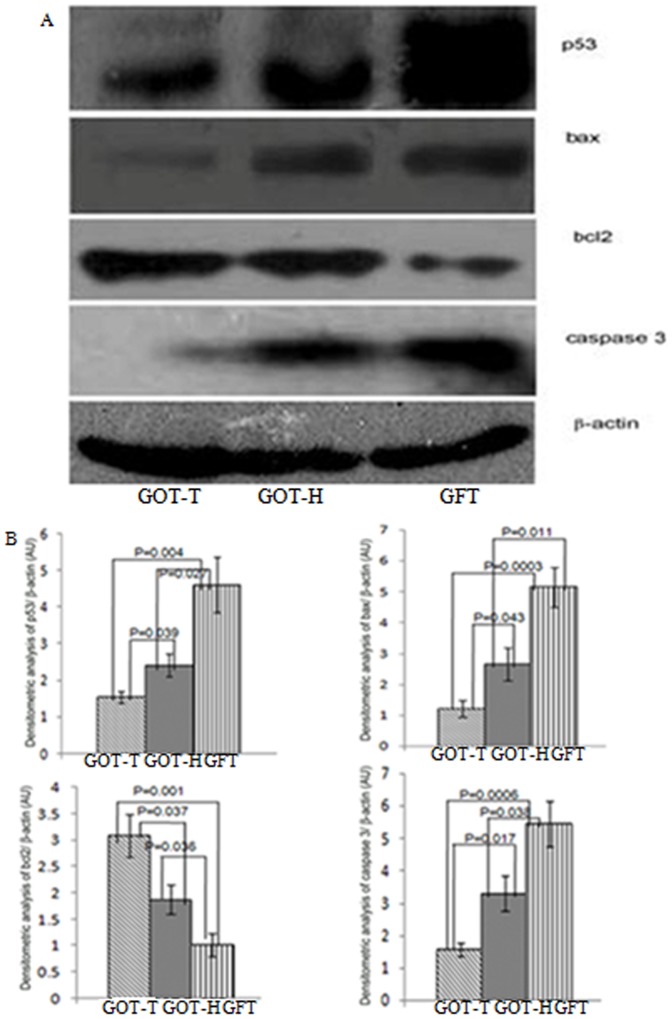
Immunoblot and densitometric analysis of p53, bax, bcl2 and caspase3.Images of representative immunoblots (Fig. 12A) demonstrate decreased expression level of pro-apoptotic factors p53, bax and caspase3, and increased expression of anti-apoptotic factor, bcl2, in both the host and transplanted ovaries of the GOT group, as compared with the expression of the corresponding factors of the follicle-deficient ovary of the GFT group. The histograms (Fig. 12B) represent the densitometric analyses with relative intensity of the bands normalized to loading control, β-actin.